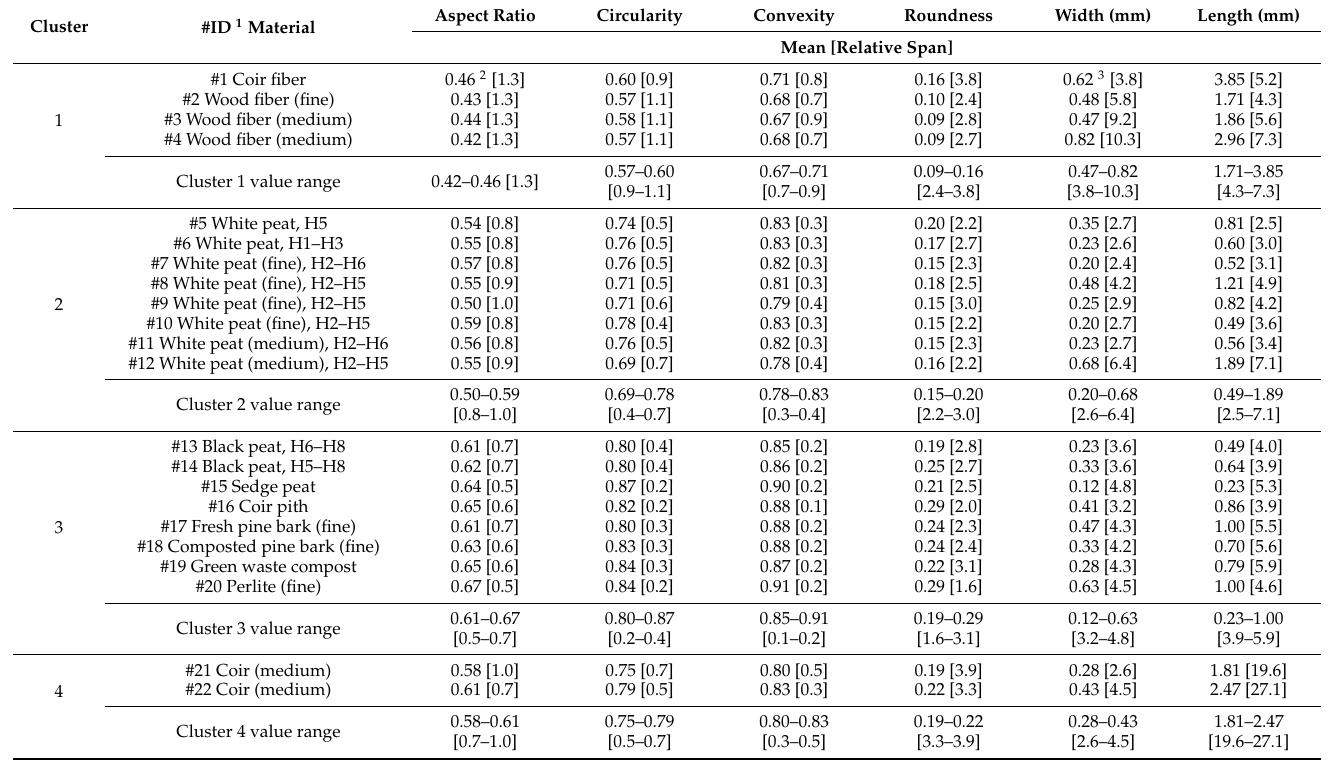
1 : Identification number defined in Table 1. 2 : Standard deviation of the mean of the shape descriptors measured on the three repetitions never exceeds 0.03. 3 : Standard deviation of the mean width and length measured over three replicates varies from several tens to several hundred